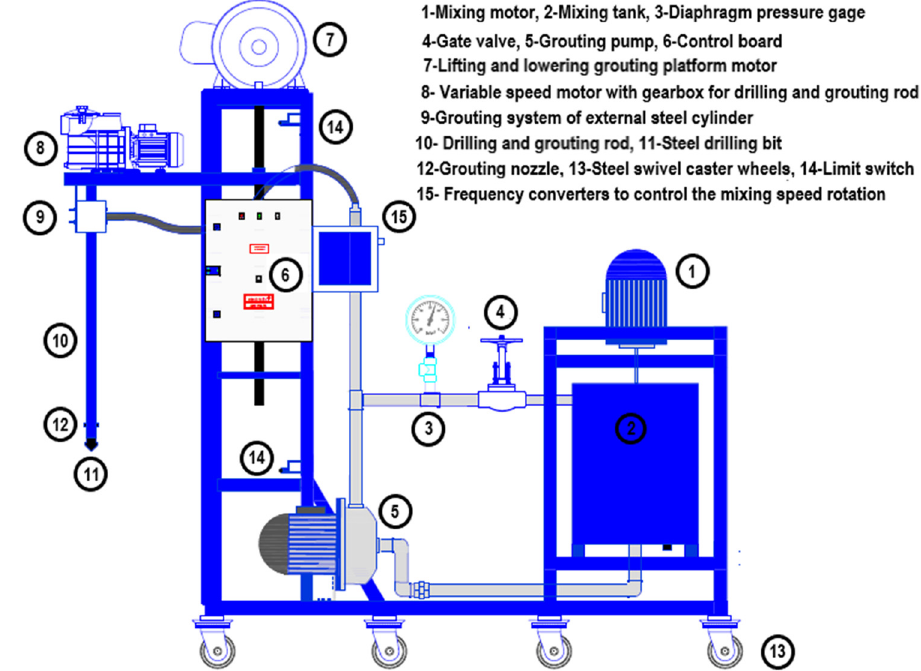
Figure 1: Schematic diagram of the low - pressure injection laboratory setup.